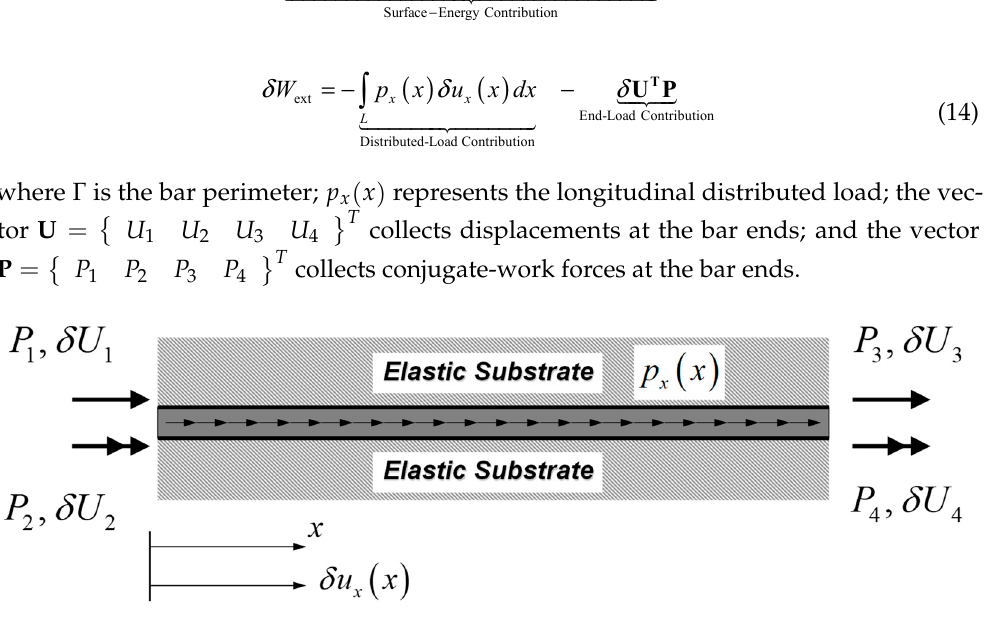
Figure 2. Nanobar-elastic substrate system: the virtual-displacement formulation.